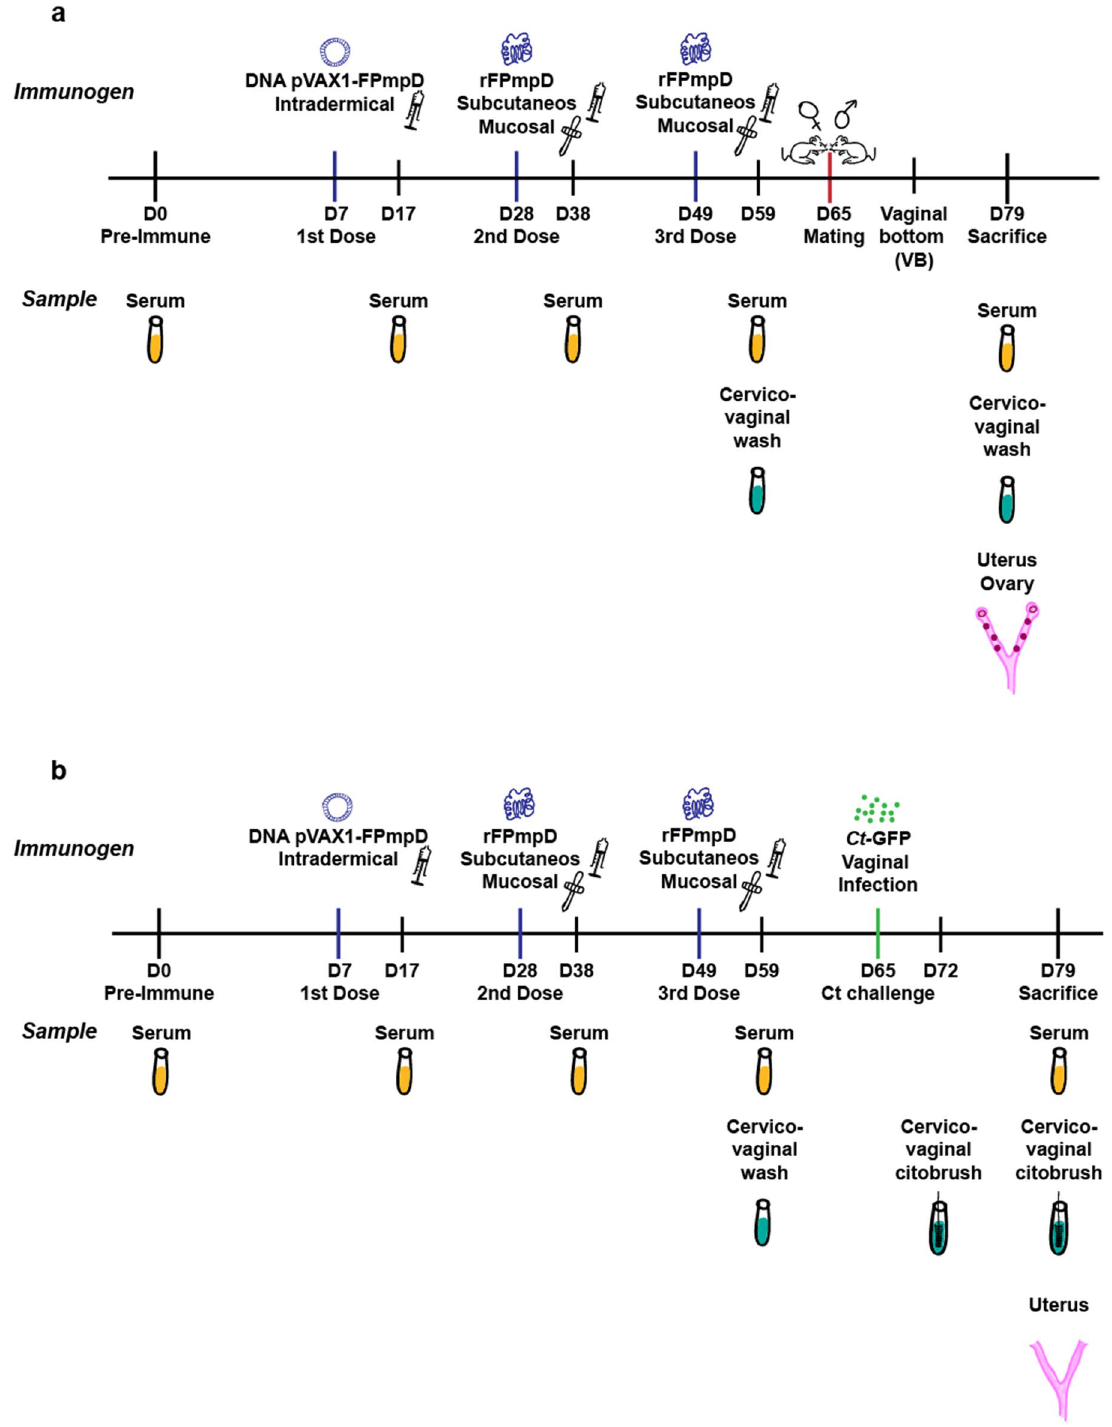
Figure 1. A timeline representing the experimental protocol for BALB/c ( a ) and C57BL/6 ( b ) mice. A schematic representation of the immunogen and administration route used for immunization, and the type of sample obtained at each time point. D indicates the experimental